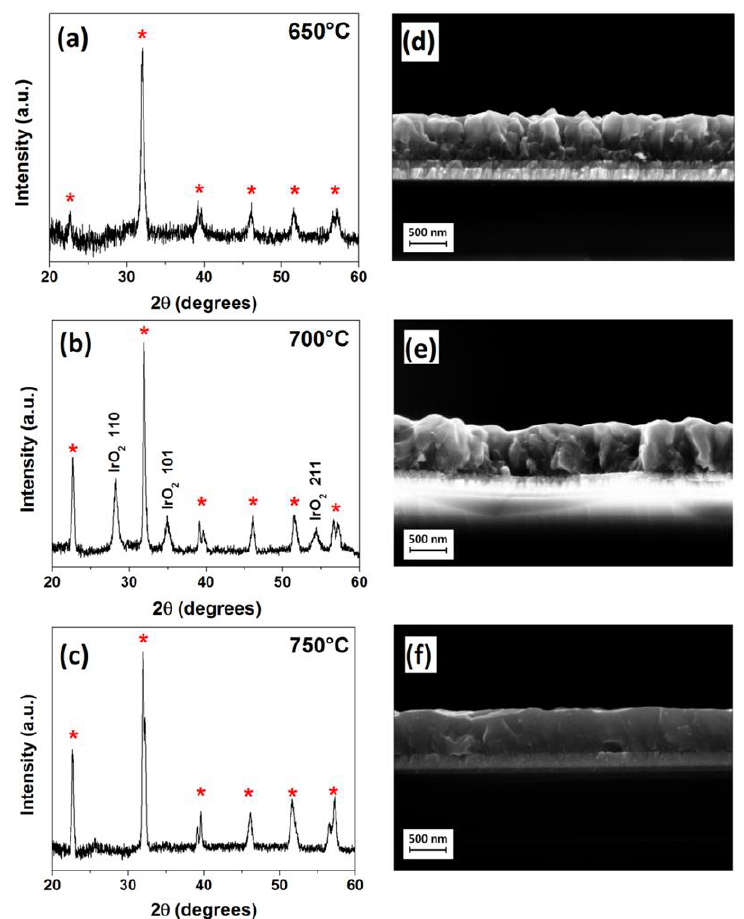
Figure 3. XRD diffraction patterns and FE-SEM cross section images of BFO thin films deposited at ( a , d ) 650 °C, ( b , e ) 700 °C, and ( c , f ) 750 °C.